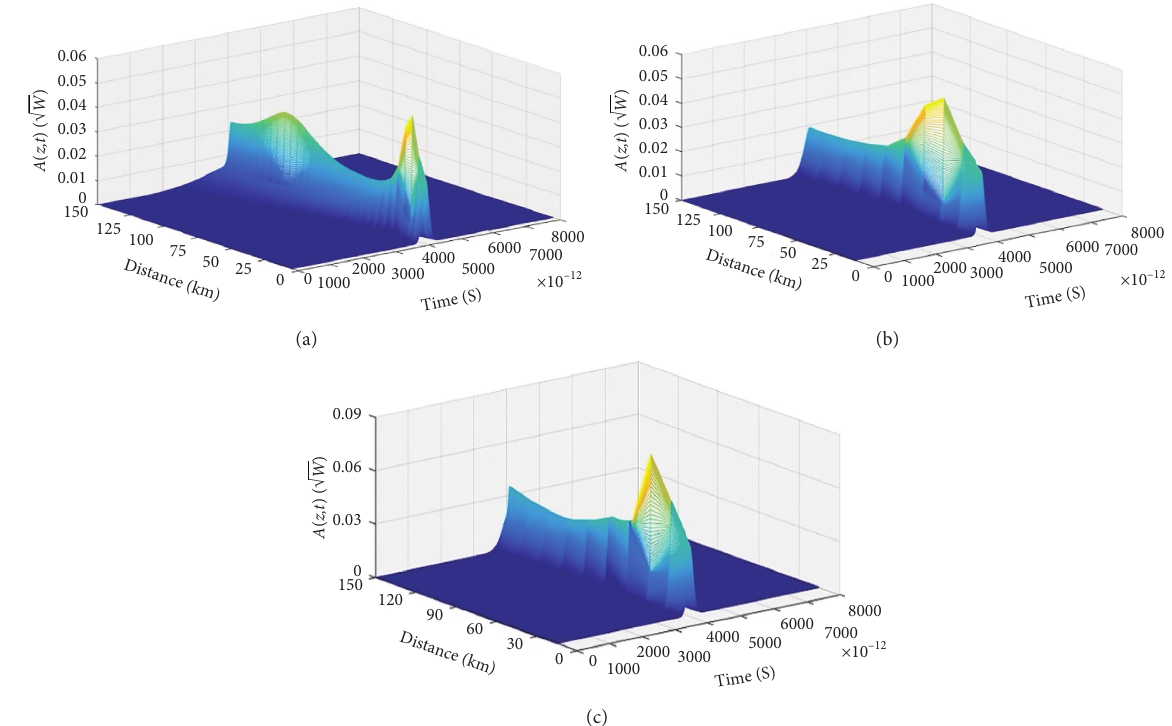
Figure 5: Output signal amplitudes of optical fiber for different values of length (a) Pin � 1mW. (b) Pin � 2mW. (c) Pin � 3mW.